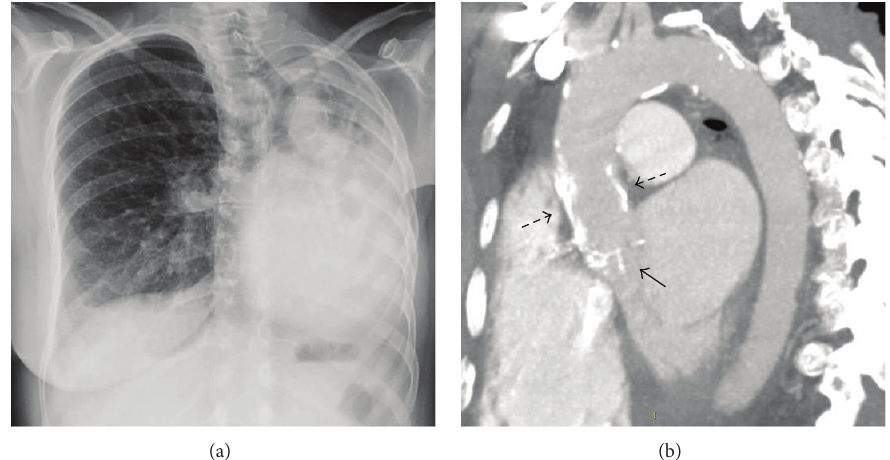
Figure 1: (a) Chest X-ray demonstrating left fibrothorax with ipsilateral mediastinum and trachea displacement. (b) CT scan demonstrating thickening and calcification of the aortic valvular leaflets (arrow) and diffuse calcification of the ascending aorta (dashed arrows).